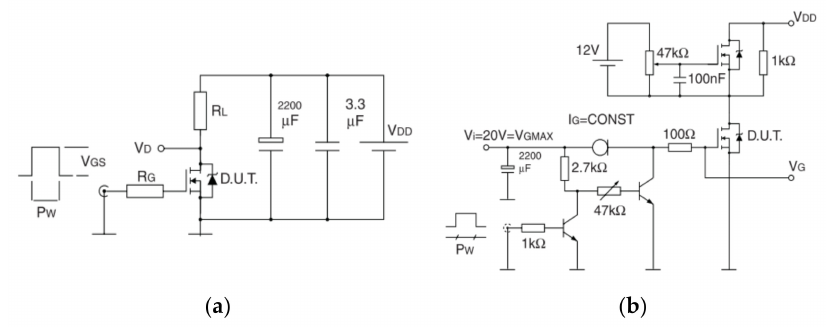
Figure 7. Switching times test circuit for resistive load ( a ) and gate charge test circuit composition ( b ).